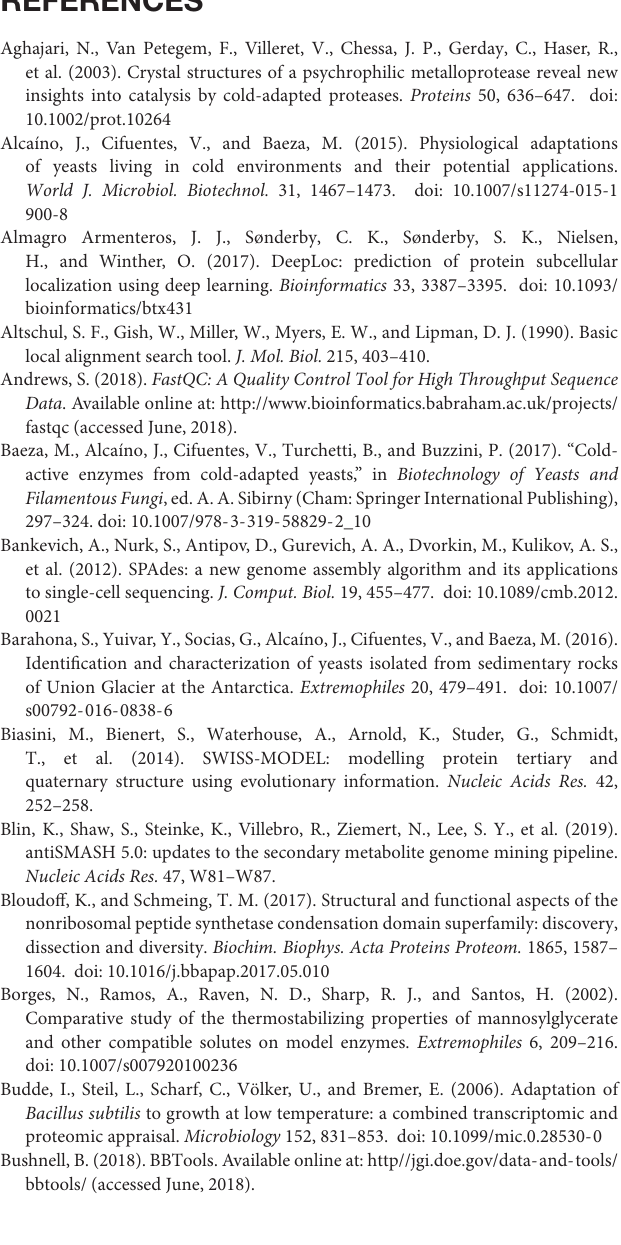
Only the results with significant differences are shown (ANOVA-Tukey, p < 0.05). least 0.7 are shown. Supplementary Table 7 | Volumes of sites active calculated for